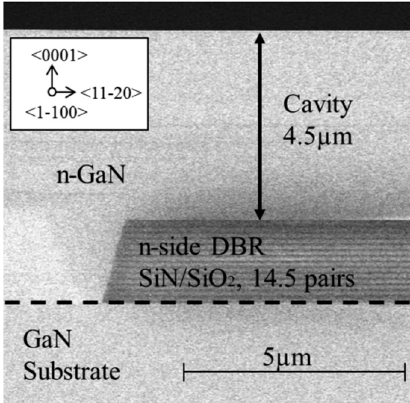
Figure 9. SEM image of the epitaxial lateral overgrowth (ELO) structure, in which the n-side DBR is encased in n-GaN grown using the ELO process. The flat surface of the epitaxial layer forms a 4.5- µ m-long cavity [54]. Copyright 2016 Phys. Status Solidi A.